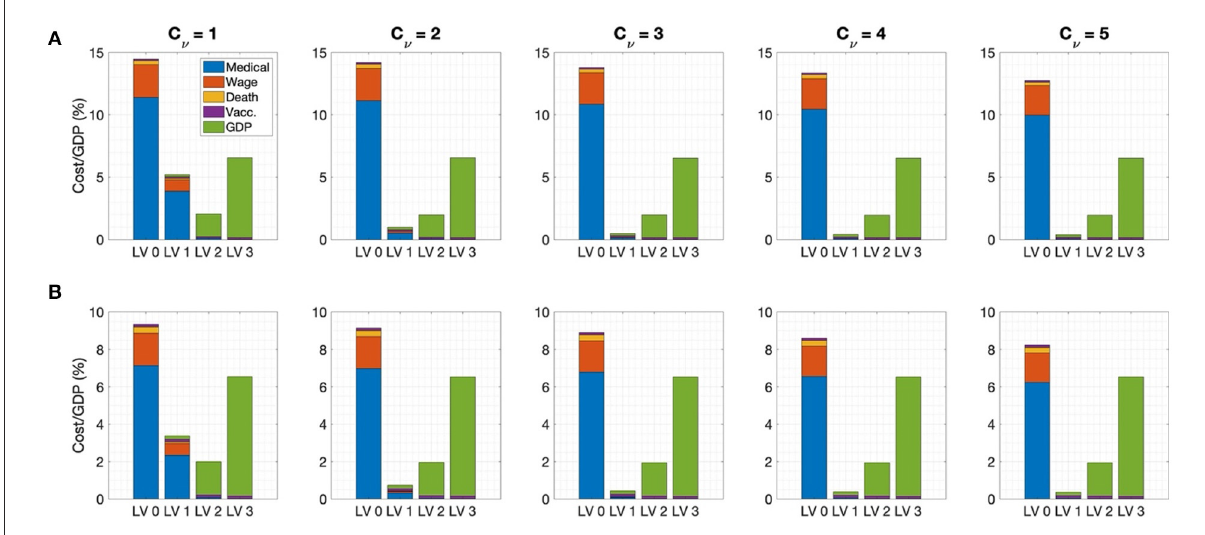
FIGURE4 Ratio of cost to GDP for C ν = 1,2, ··· , 5 for (A) admission to the treatment center for mild patients (B) home treatment for mild